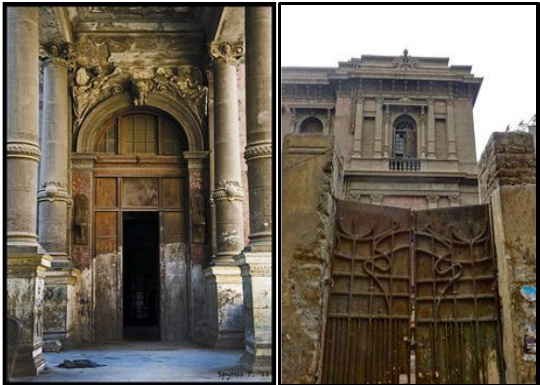
Figure (7): Statistics on master’s thesis numbers increase issued by The Faculty of Fine arts-Cairo through the last twenty years that focuses on historical palaces and heritage themes in Egypt. ( x) : Scale of Masters’ Thesis Numbers - ( y) : Scale of Years) Source: Done by the authors. Data has been collected through the documented statistics of masters’ thesis library of The Faculty of Fine